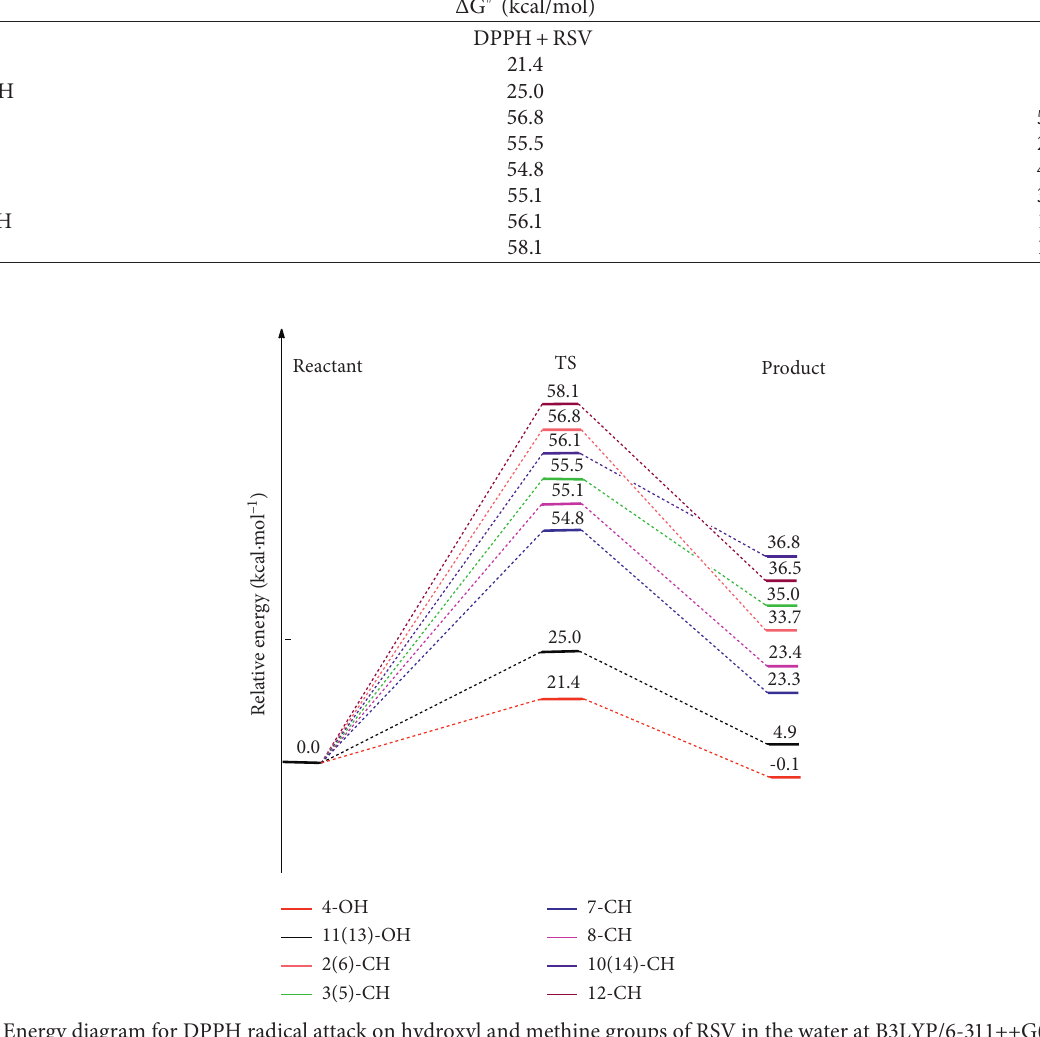
Figure 5: Energy diagram for DPPH radical attack on hydroxyl and methine groups of RSV in the water at B3LYP/6-311++G(d, p) level of theory.